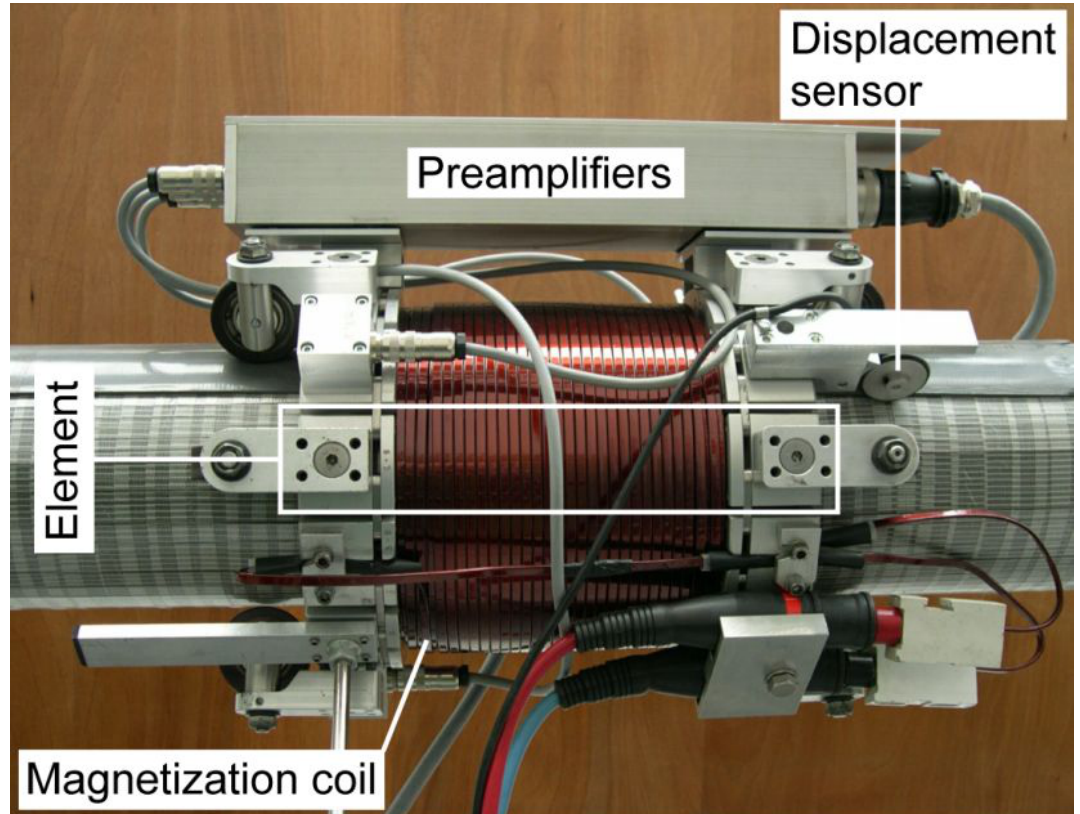
Figure 1. Inspection device developed at Empa